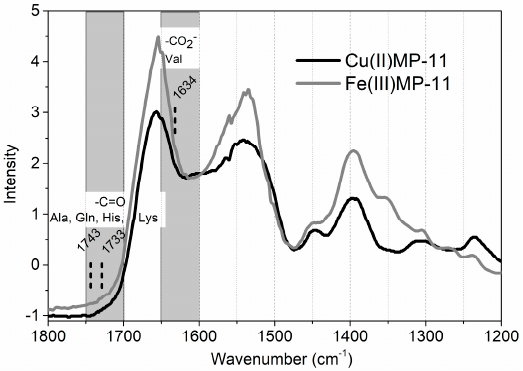
Figure 6. FTIR spectra of Cu(II) (black line) and Fe(III)MP-11 (gray line) and the spectral regions where the vibrational bands of Cu(II) complexed with carbonyl groups of Ala, Gln, His and Lys and the region of Val complexed with Cu(II) are expected.